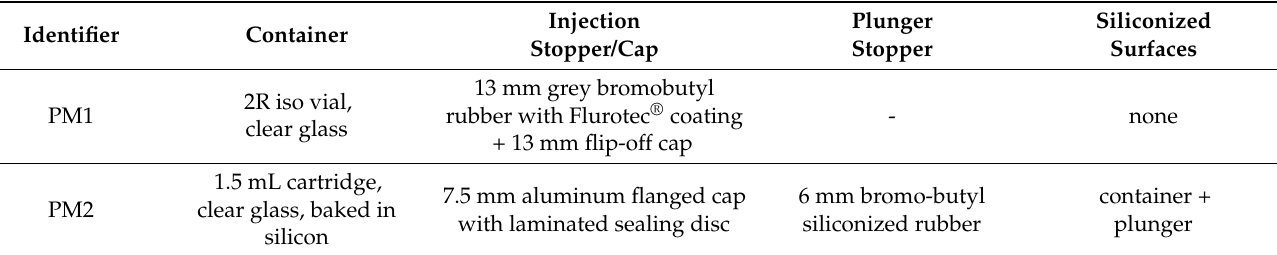
Table 2. Primary packaging materials (PM1, PM2) used for